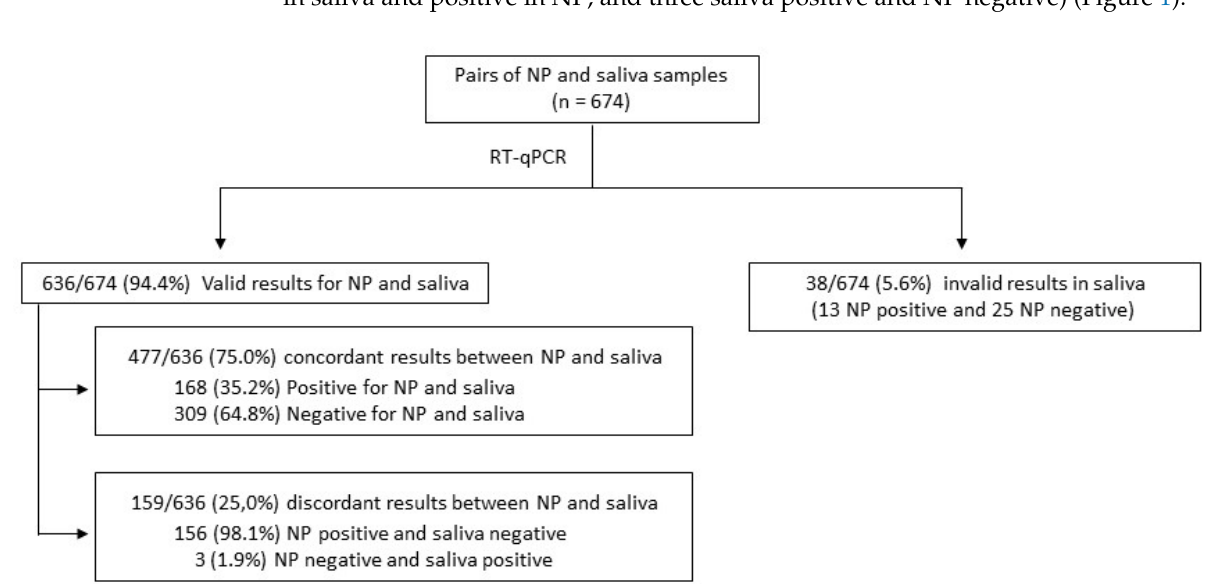
Figure 1. Summary of RT-qPCR results in saliva and nasopharyngeal (NP) samples.